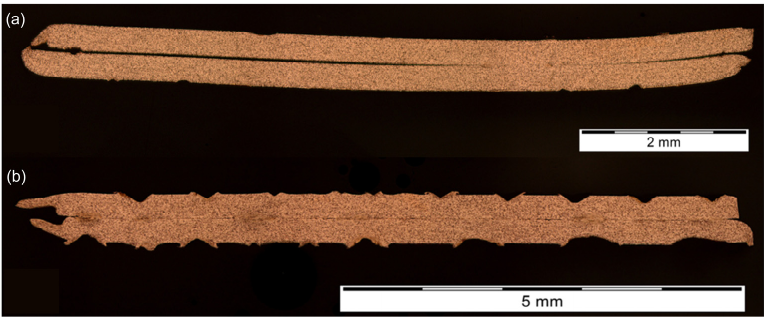
Figure 16. Metallographic images (×50) of etched Cu–Cu welds with t = 0.3 mm for increasing pressure: ( a ) 1.5 bar; ( b ) 3.00 bar.